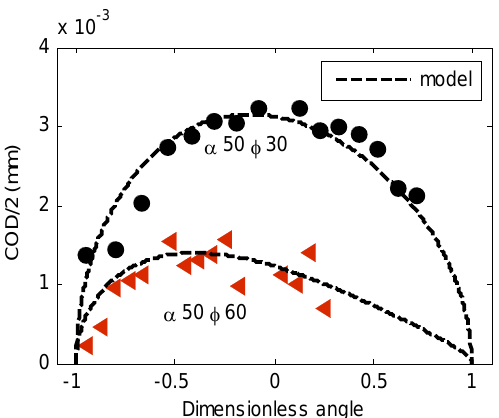
Figure 7: t=2 mm crack length 2  (  0°) and ( 